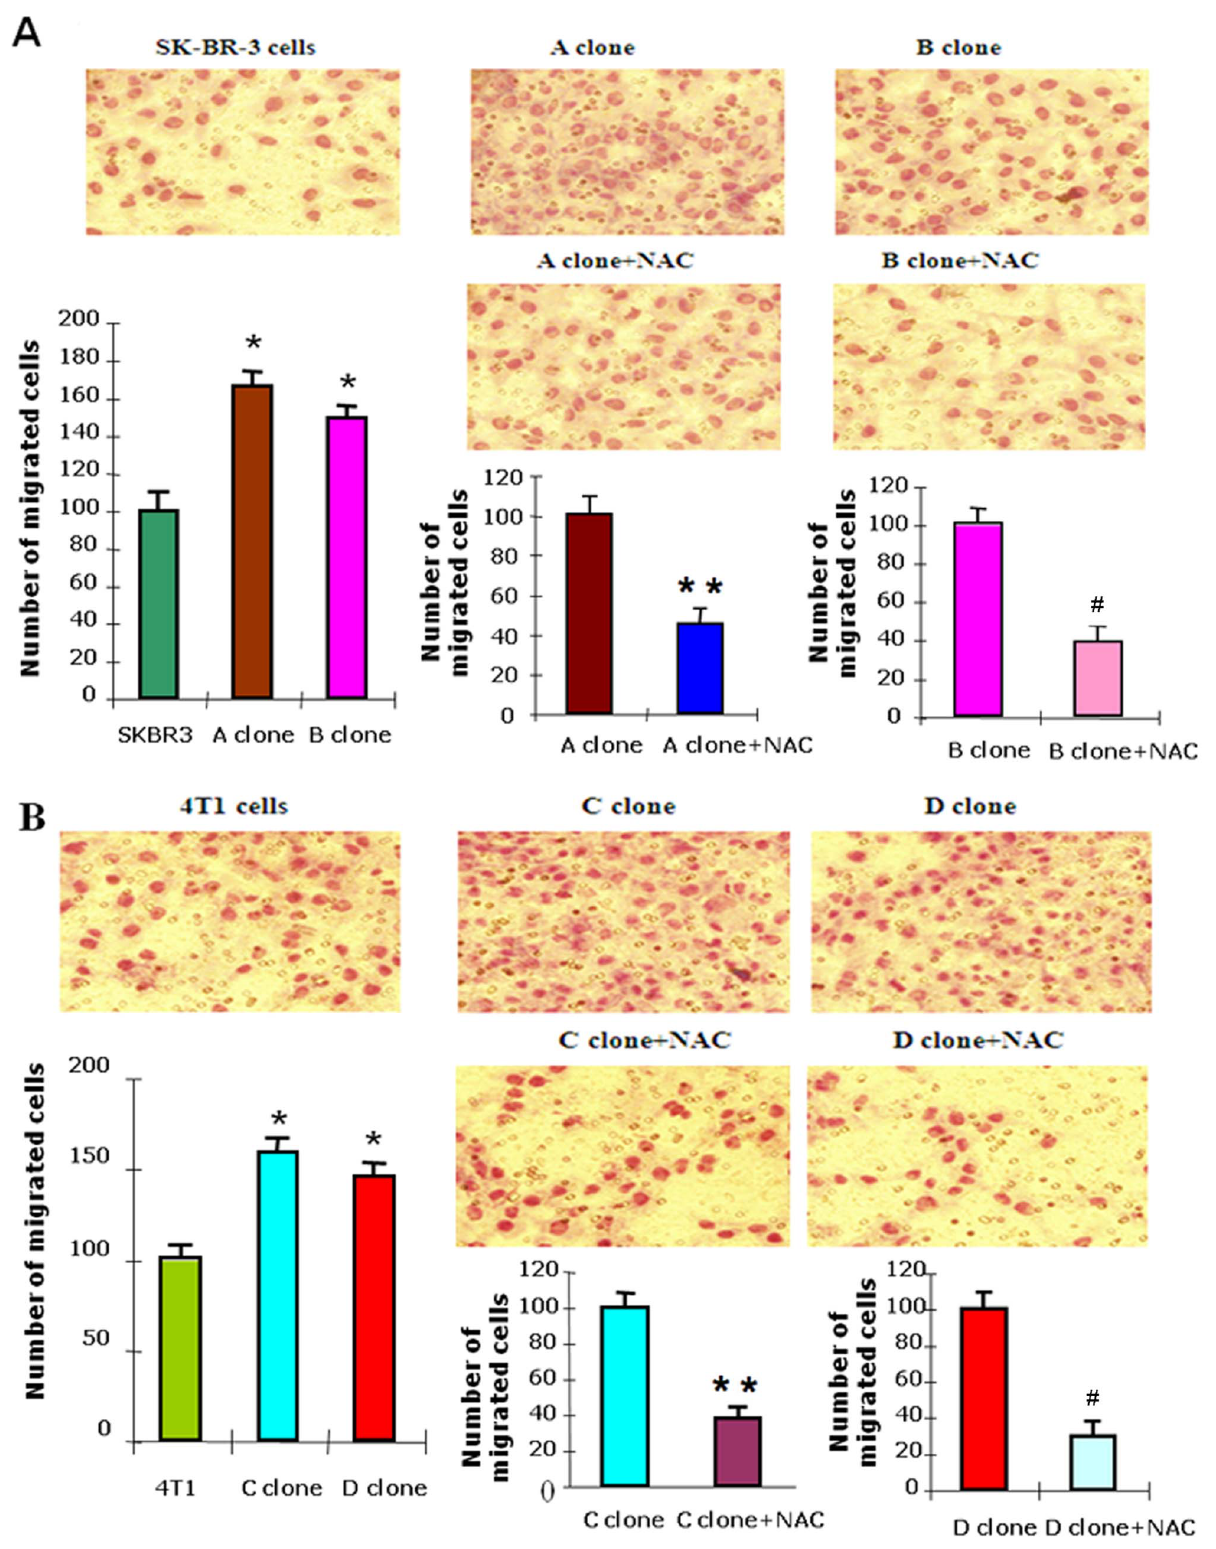
Figure 2. Effect of ROS on migration and invasion capacity of subclones and their parental cells by transwell assay. A, SKBR3 subclones migrated faster than parental SKBR3 cells. NAC was able to effectively inhibit the migration of SKBR3 subclones. *P , 0.05 vs SKBR3 cells, **P , 0.01 vs A clone, # P , 0.01 vs B clone (n=3). B, 4T1 subclones migrated faster than parental 4T1 cells. NAC was able to effectively inhibit the migration of 4T1 subclones. *P , 0.05 vs 4T1 cells, **P , 0.01 vs C clone, # P , 0.01 vs D clones (n=3).